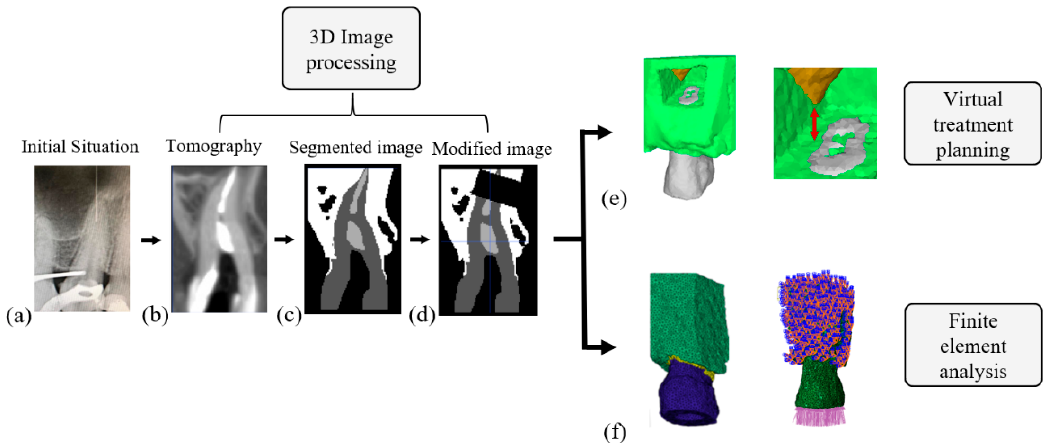
Figure 1. The process for a patient-specific biomechanical analysis and detailed steps for virtual treatment planning and finite element analysis: ( a ) radiograph of the initial situation presenting a fractured instrument, ( b ) cone beam computed tomography axial view with temporary intracanal medication, ( c ) segmentation based on a growing region algorithm, ( d ) transformation of the initial 3D image to simulate a 3 mm apicoectomy, ( e ) analysis of the 3D simulated treatment, and ( f ) meshing of the 3D transformed image to get a finite element model and application of boundary